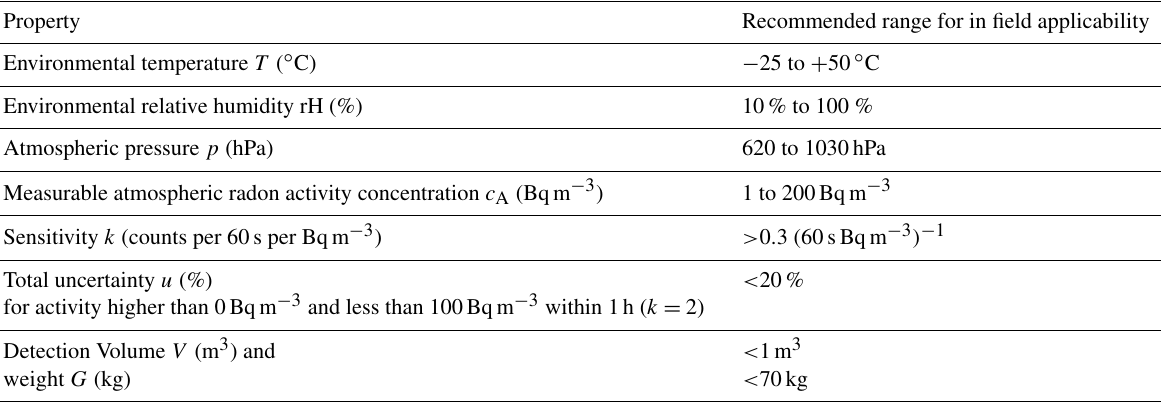
Table 2. Matrix of recommended properties for the in-field application of a transfer standard radon monitor for atmospheric measurements. Property Recommended range for in field